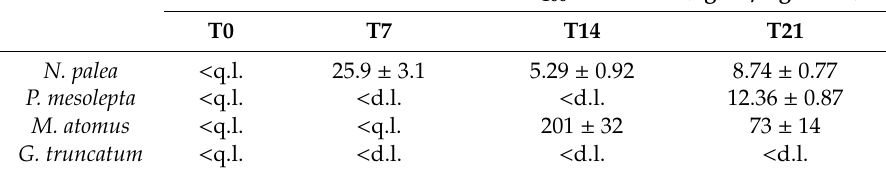
Table 2. Mean cadmium bioaccumulation levels in the diatoms (ng Cd / mg Chl- a ± standard error) at the di ff erent sampling times for Cd 100 treatment. Detection (d.l.) and quantification (q.l.) limits were 0.09 and 0.56 µ g Cd / L, respectively (after digestion in the solution of nitric acid and hydrogen peroxide). Cd concentrations for control treatment were below the detection limit at all sampling times and are not